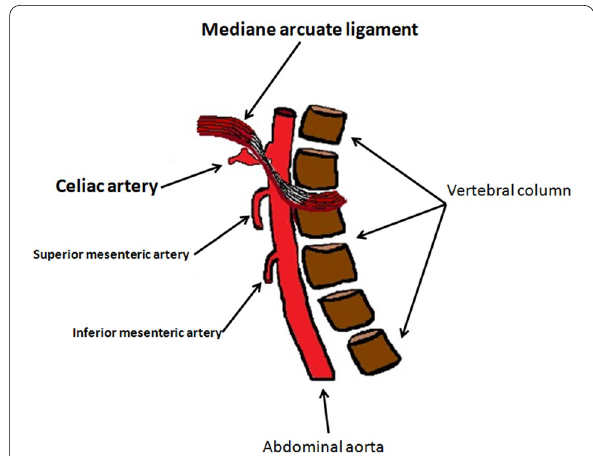
Fig. 15 DS. Scheme summarizing of the anatomical structures involved in DS. More caudal course of the MAL that compresses the CA in the expiratory apnea